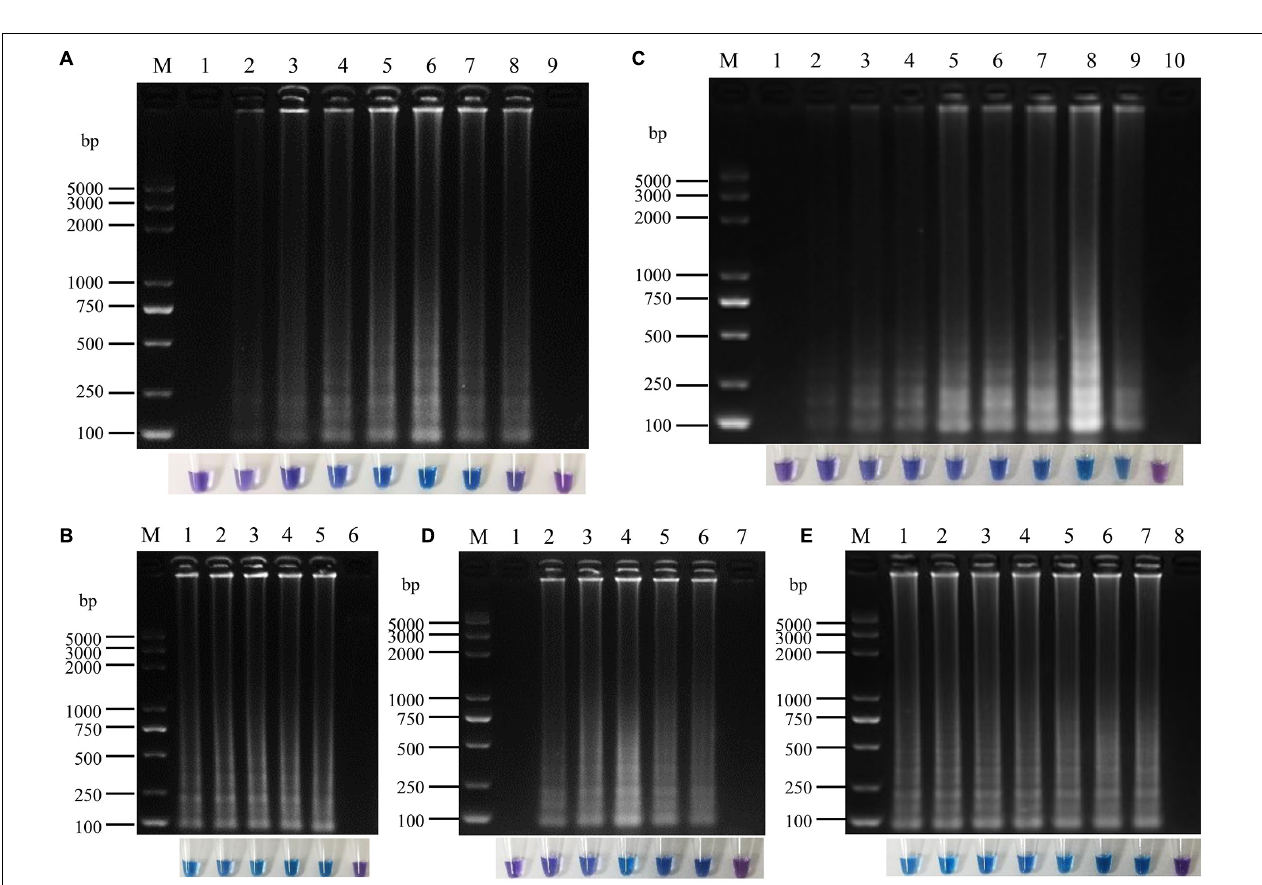
FIGURE 4 | Optimization of loop-mediated isothermal amplification (LAMP) reaction system for P. vexans. (A) The reaction time of lanes 1–8 were 10, 20, 30, 40, 50, 60, 70, and 80 min, lane 9 was negative control. (B) The reaction temperature of lanes 1–5 were 60, 62, 64, 66, and 68 ◦ , lane 6 was negative control. (C) Lanes 1–9 corresponded to 0, 0.2, 0.4, 0.6, 0.8, 1.0, 1.2, 1.4, and 1.6 mM dNTPs, respectively, and lane 10 was negative control. (D) Lanes 1–6 indicated that the concentrations of MgSO 4 were 0, 2, 4, 6, 8, and 10 mM, respectively, lane 7 was negative control. (E) Lanes 1–7 indicated that the concentrations of betaine were 0, 0.2, 0.4, 0.6, 0.8, 1.0, and 1.2 M, lane 8 was negative control. In all optimizations, a negative control was set up that contained pure sterilized distilled water without any template